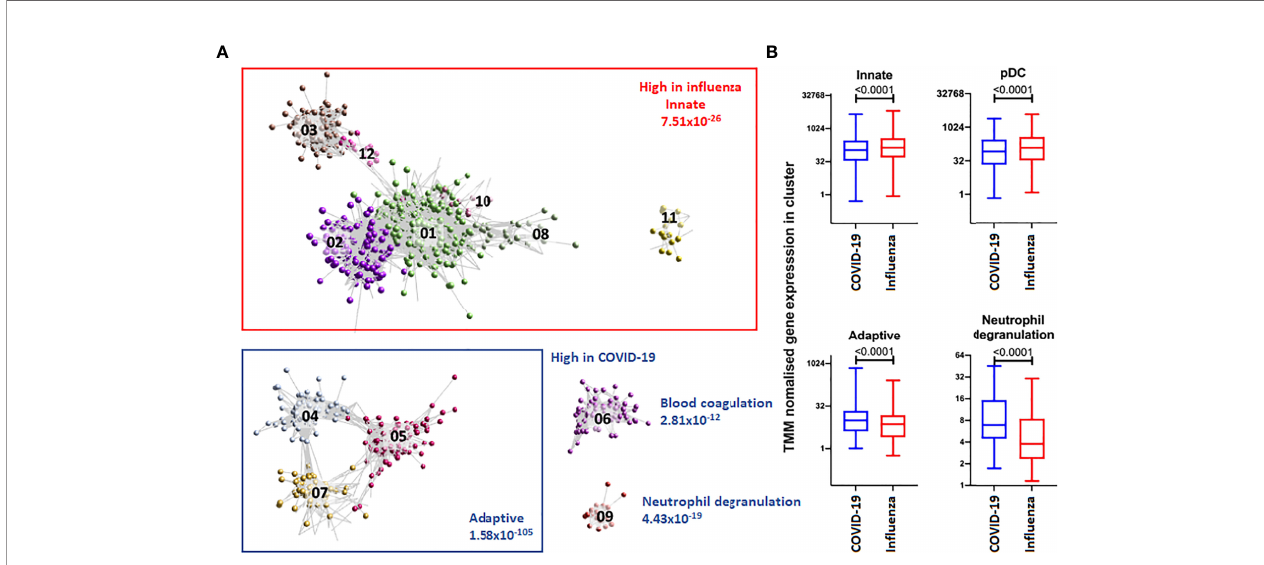
FIGURE 1 | Top 12 clusters identi fi ed with BioLayout. (A) Enrichment of gene clusters in blood of patients with in fl uenza (annotated in red) and COVID-19 (annotated in blue). Increased abundances of gene transcripts in in fl uenza patients are involved with an innate immune response, while in COVID-19 clusters are involved with an adaptive immune response, blood coagulation and neutrophil degranulation. (B) After TMM normalisation a signi fi cant difference in gene clusters between patients with in fl uenza or COVID-19 was detected. The abundance of gene transcripts involved with an innate immune response and plasmacytoid dendritic cell were observed to be higher in in fl uenza patients. In contrast, the abundance of gene transcripts involved with an adaptive immune response and neutrophil degranulation was higher in COVID-19 patients.